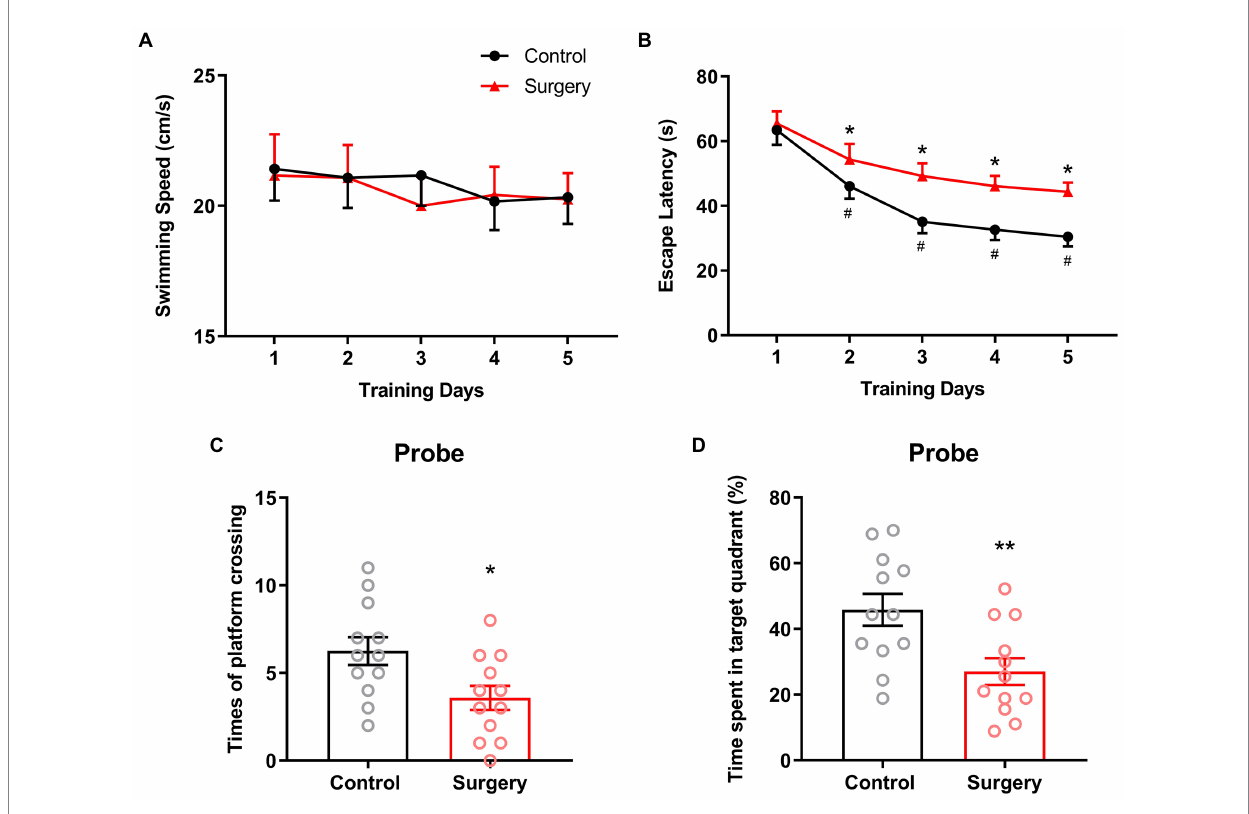
FIGURE 9 Morris water maze test showed that in the place navigation test, the swimming speed did not change significantly in both groups (A) , but the escape latency increased significantly after surgery (B) . In the probe test, both the times of platform crossing (C) and the time spent in target quadrant (D) decreased significantly after surgery. (Means ± SD, * p < 0.05, ** p <